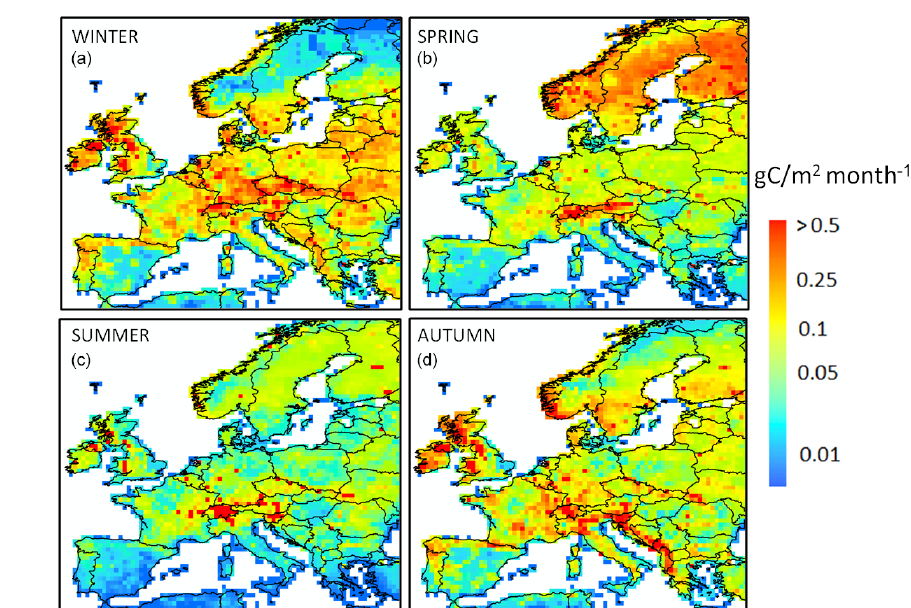
Figure 8. Seasonal distribution of the terrestrial DOC leaching flux (gCm − 2 per month) for (a) winter, (b) spring, (c) summer and (d) au- tumn, averaged over the period 1979–2006. A logarithmic scale is used to better highlight the spatiotemporal gradients.